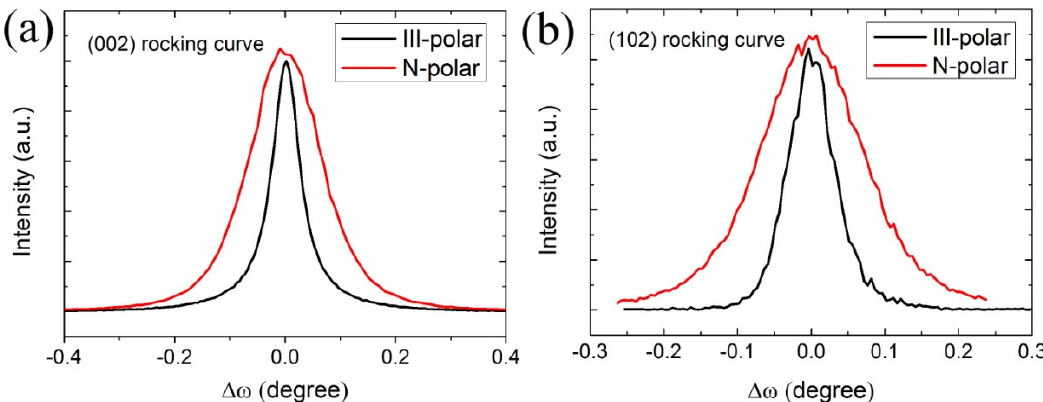
Figure 1. HRXRD (002) ( a ) and (102) ( b ) RC scans of planar III- and N-polar samples for dislocation estimation.